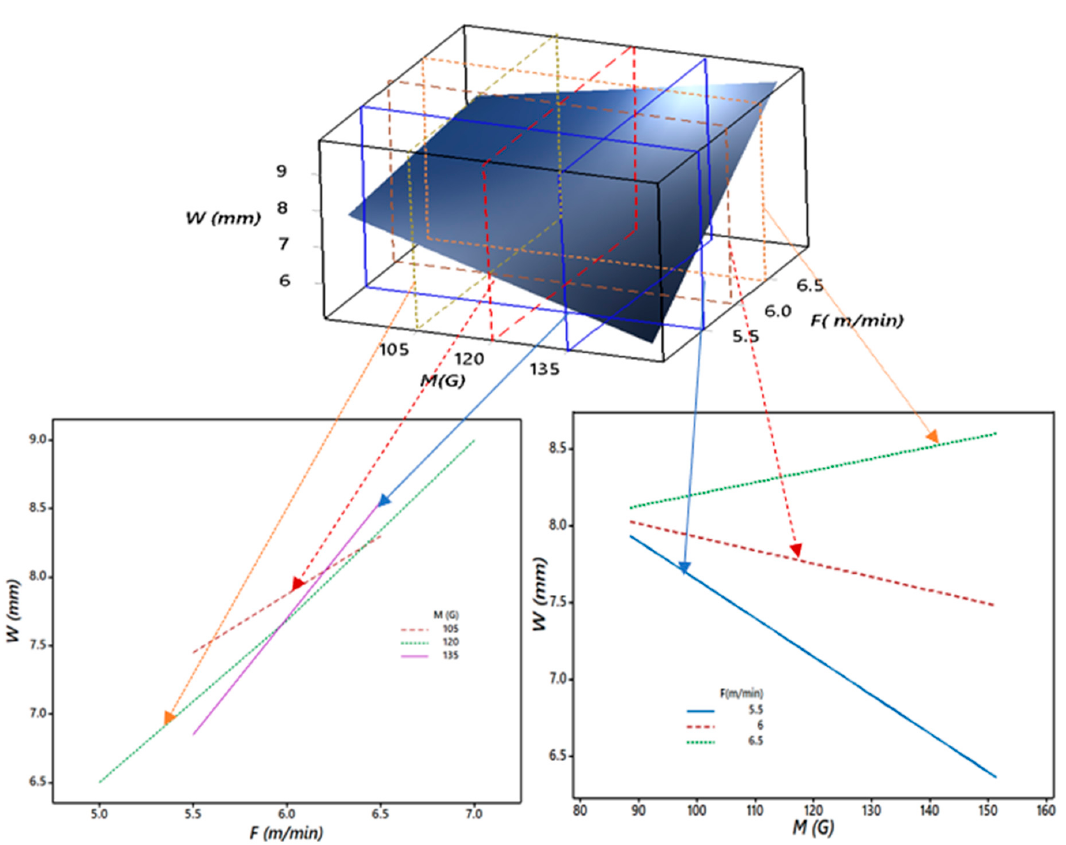
ff ects of M and F on W